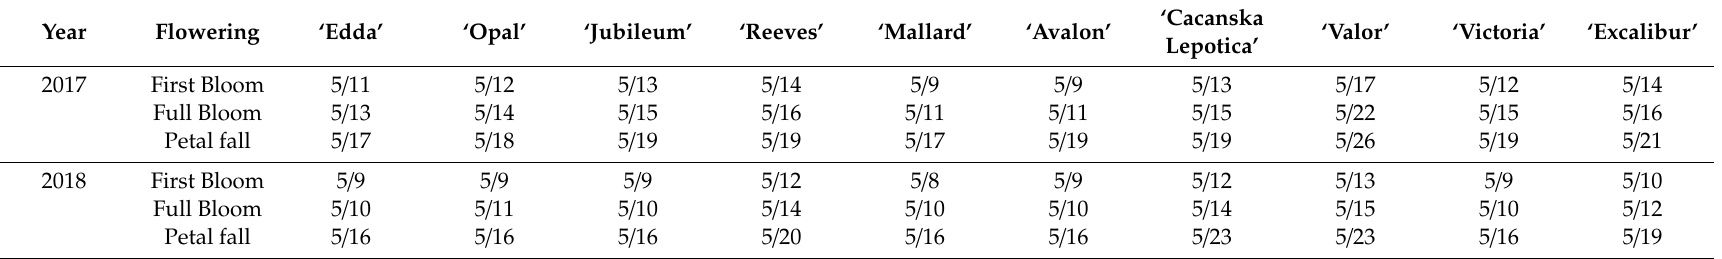
Table 5. Dates of first bloom (10% of flowers open), full bloom (80% of flowers open), and petal fall in May for 10 investigated plum cultivars and their pollinizer cultivars in Ullensvang, Norway during 2017 and 2018